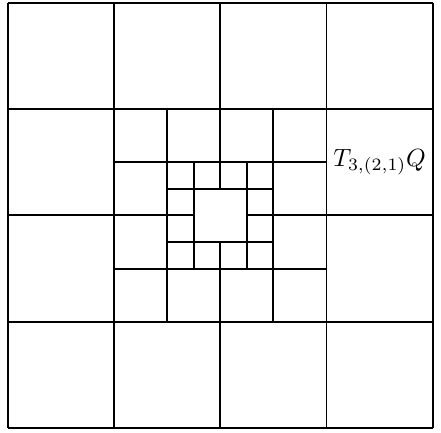
Figure 1 . A decomposition of the frequency plane using the structured family T from Section 8.1.1 on a fixed cube